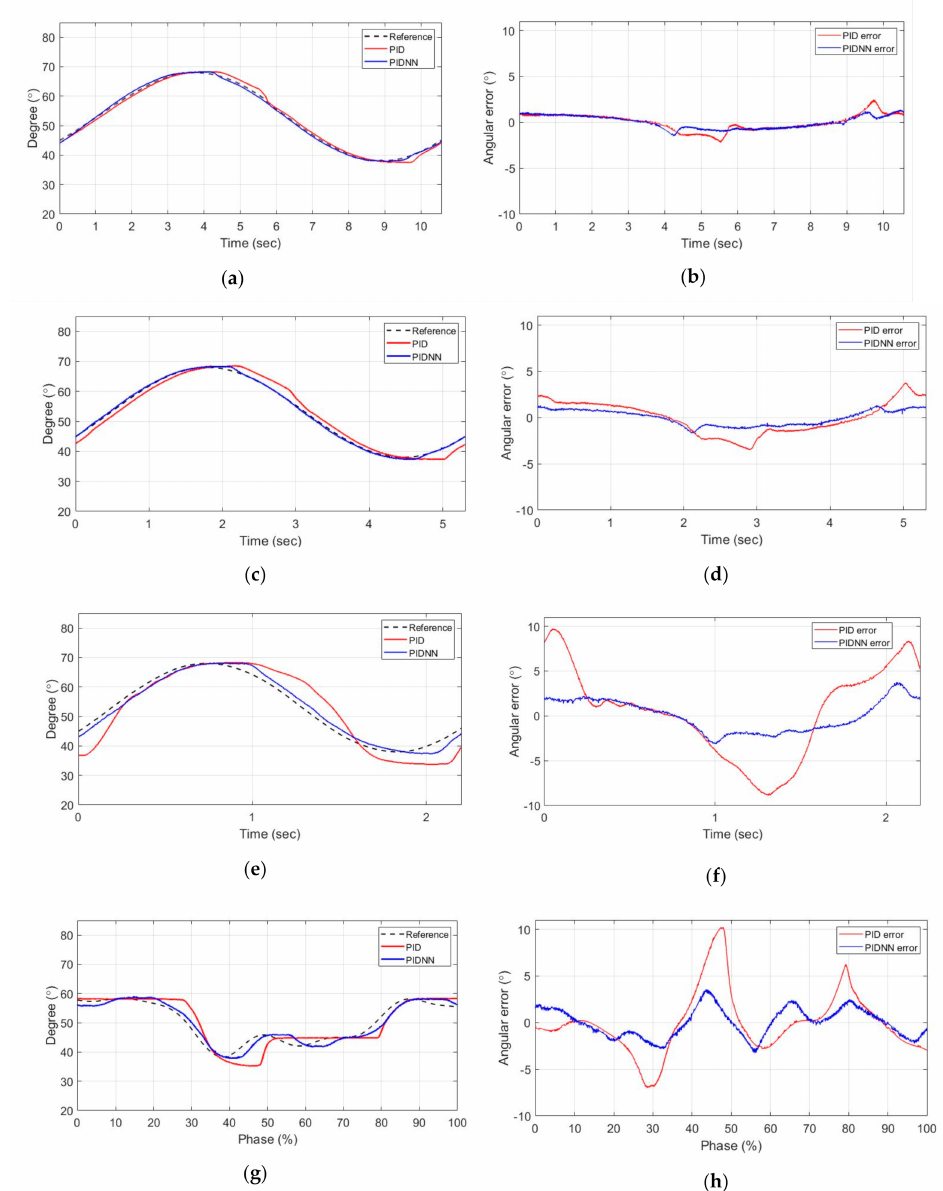
Figure 12. Experimental results of the PID Neural Network control (PIDNN) and PID control: ( a , c , e , g ) Results of the angular position estimation performance; ( b , d , f , h ) Results of the angle tracking error. (From top to bottom, 0.1 Hz, 0.2 Hz, 0.4 Hz, walking pattern).